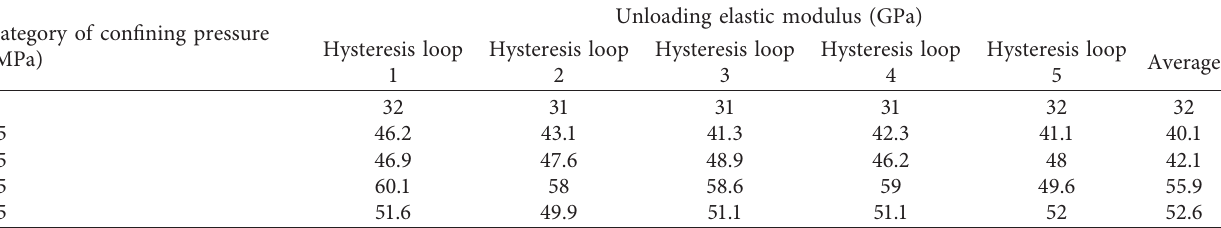
Table 5: Unloading elastic modulus of hysteresis loops under various confining pressures.